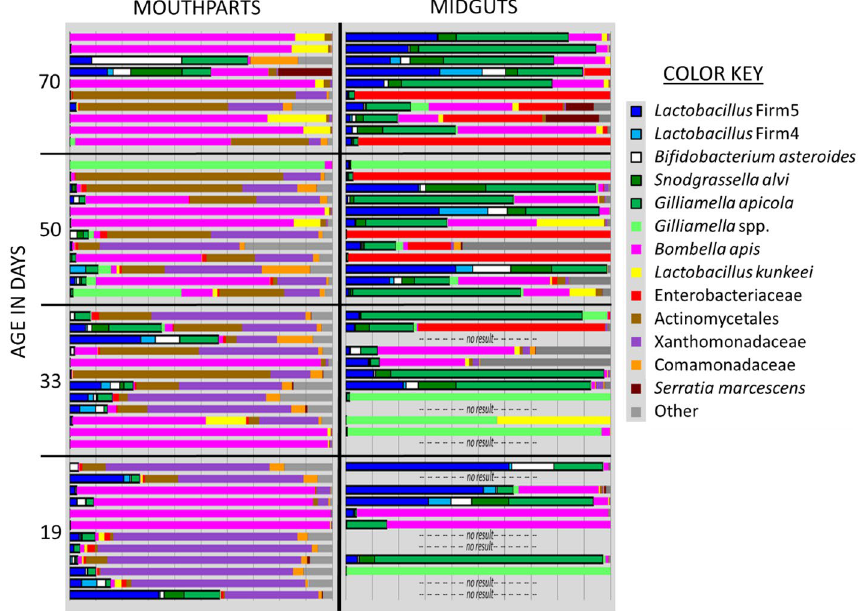
Figure 3. Relative OTU abundance for mouthpart ( n = 46) and midgut ( n = 38) microbiotas of KA worker bees maintained in Tucson AZ, USA. The five core hindgut bacteria at the top of the key are outlined with a black border. Ages on the y-axis coincide with sampling dates; Newly emerged bees were marked and introduced to colonies in Early December, then sampled in late December at 19 days old, mid-January at 33 days old, late January at 50 Days old and mid-February at 70 days old. Significantly larger microbiotas are associated with B. apis (Pink) on the mouthparts, and Enterobacteriacae (Red) and Gilliamella spp. (GFP green) in the